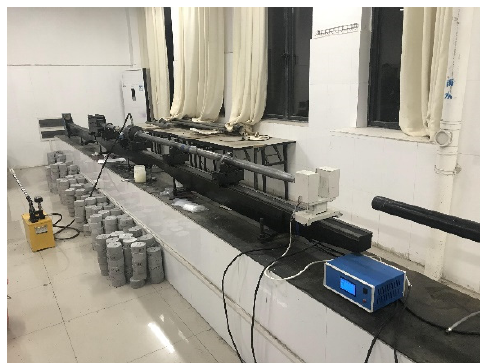
Figure 1. SHPB test system.